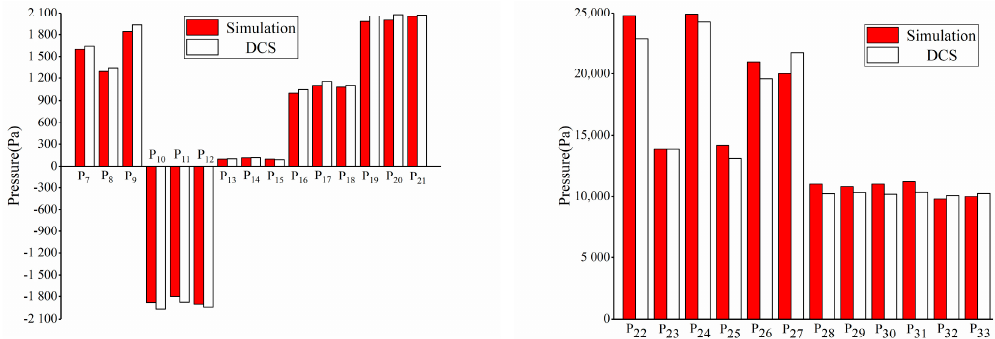
Figure 17. Comparison of simulated and measured pressure of the whole circuit.